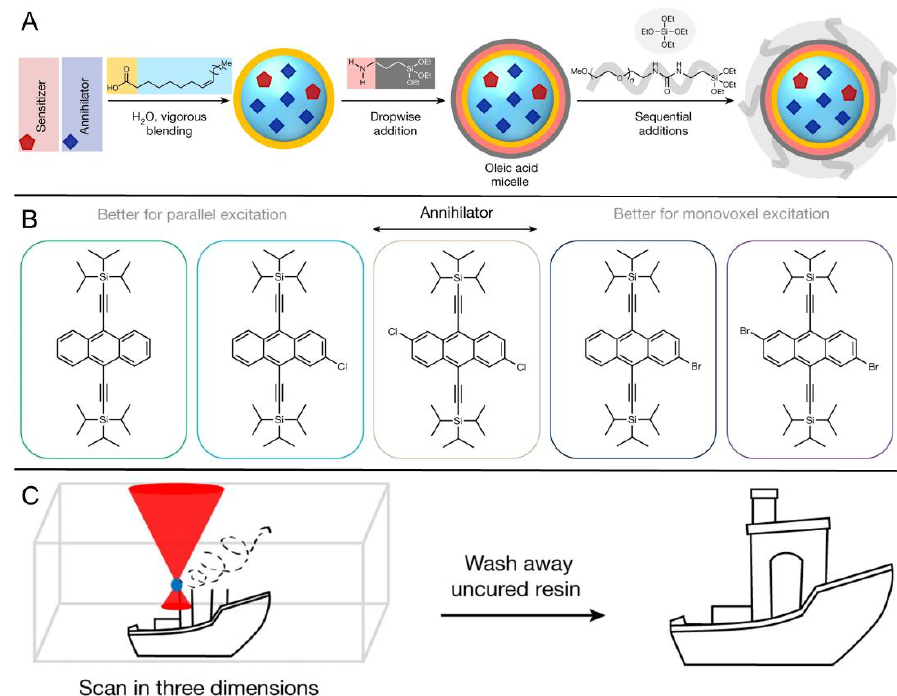
Figure 7. Schematic diagram of 3D printing based on TTAP: ( A ) Synthesis routes of the UCNP, ( B ) the chemical structures of selected annihilators, and ( C ) cartoon diagram of the 3D printing process in monovoxel printing mode. Reprinted with permission from ref. [70]. Copyright 2022 Springer Nature.